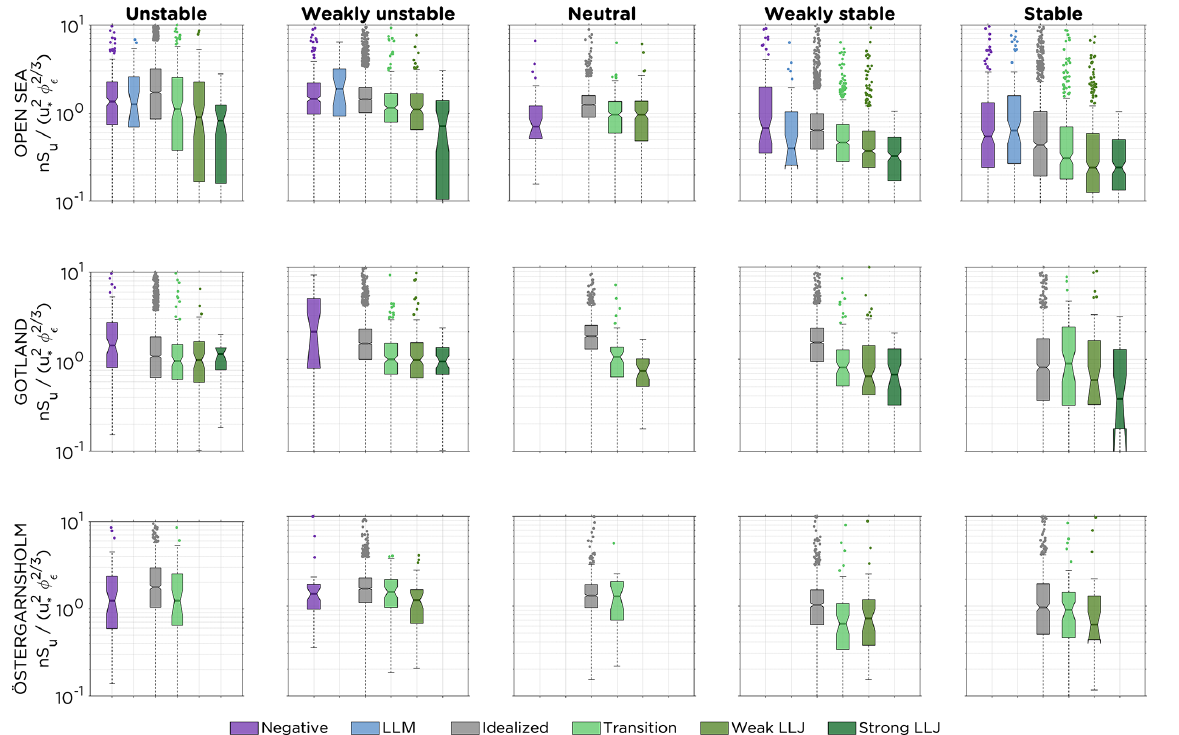
Figure 9. Distribution of normalized spectral values of u power spectra for the different wind profile classes for the selected normalized frequency of 0.01 (compare with Fig. 8). The data are categorized based on wind direction sector and the stability of the atmospheric surface layer during the time of occurrence of the wind profile. The line in the boxes mark the median value, and the bottom and top edges mark the 25th and 75th percentiles, respectively. The dots indicate the outliers, and the whiskers indicate the most extreme spectral values not considered outliers. The notches mark the 95% confidence interval of the